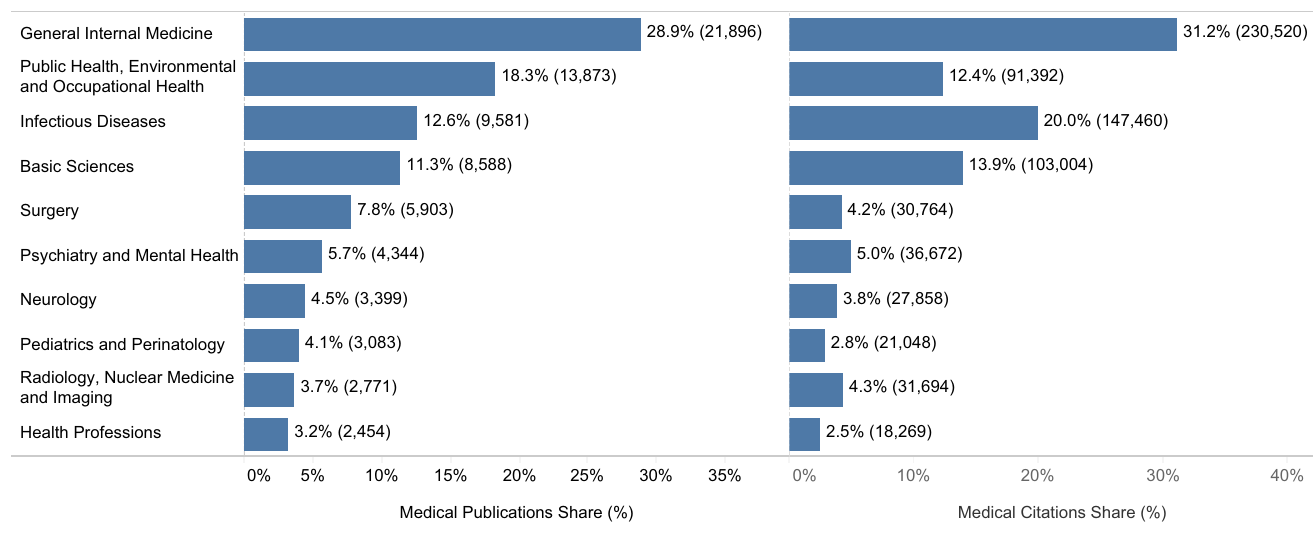
Fig 5. Share of the top ten medical subjects in the number of medical publications and citations.